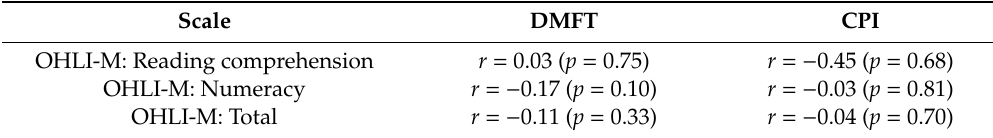
Table 4. Correlation between OHLI-M, DMFT and community CPI for concurrent validity ( n = 85). Scale DMFT